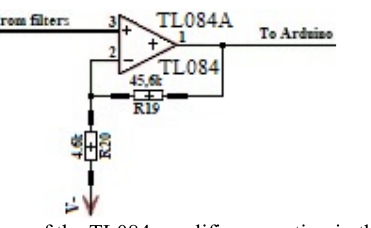
Fig. 4. Diagram of the TL084 amplifier operating in the closed feedback loop.